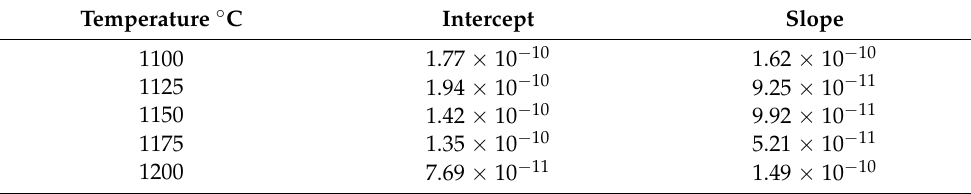
Table 3. Slopes and intercepts of the fitted straight lines at different casting